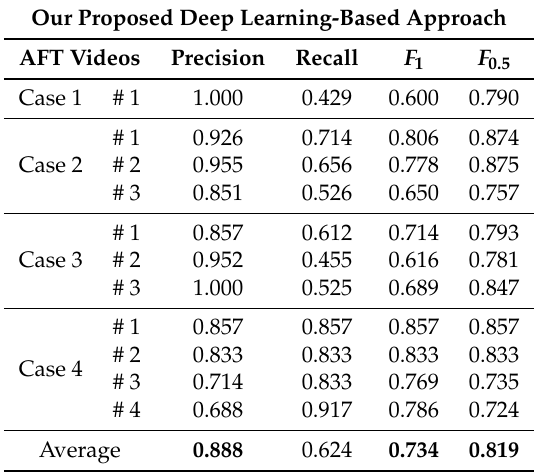
Table 3. The quantitative results for the AFT videos in terms of the precision, recall, and F-measures.